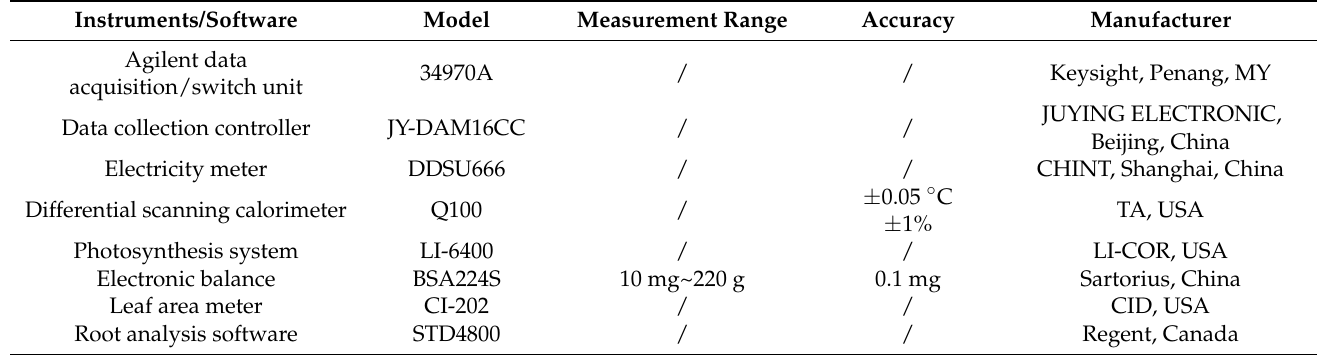
Table 2. Detail information of the